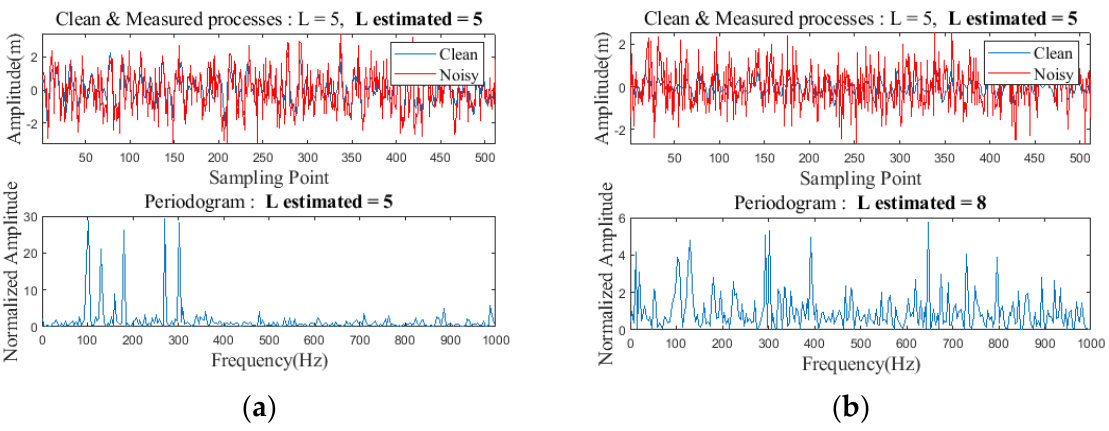
Figure 3. Estimation of the WSAW number, where the simulated underwater sound source excites five signals of different frequencies. ( a ) It shows the estimation results of the above algorithm and periodogram under high SNR and ( b ) low SNR conditions.